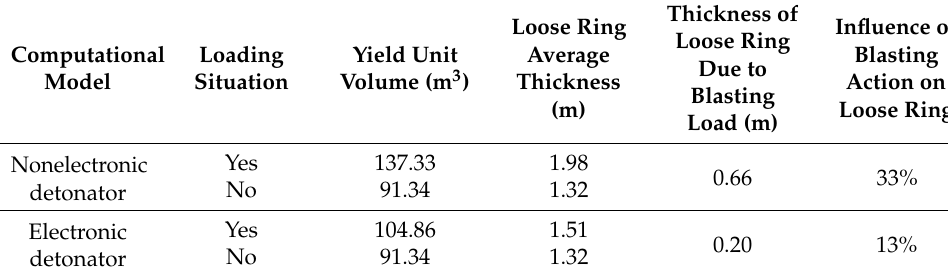
Table 5. The average thickness of the loose ring in the comparative test.